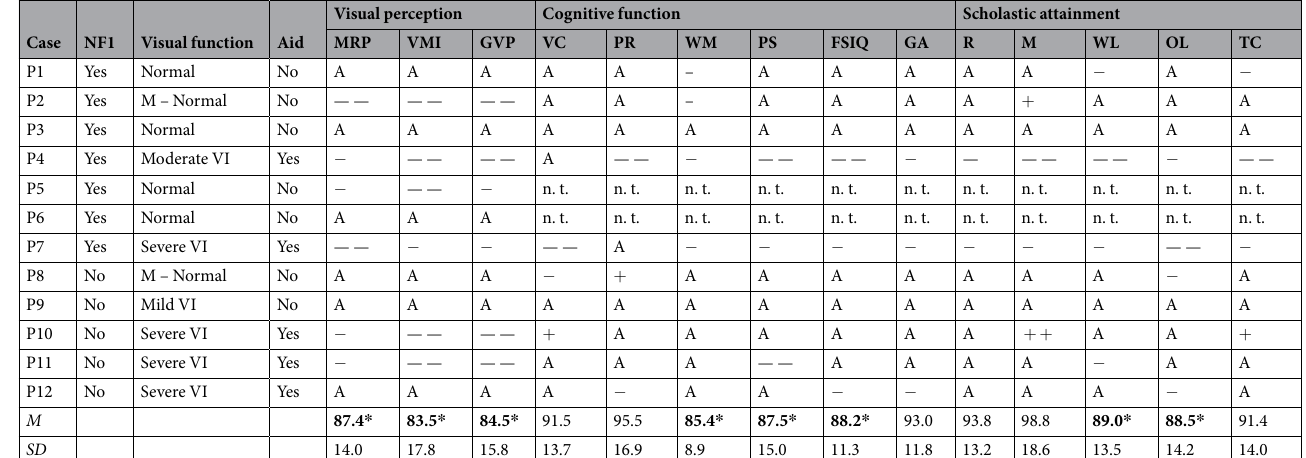
Table 1. Individual profile of neuropsychological performance of the study participants on individual and composite indices; group statistics (mean and standard deviation) compared to test norms given below.